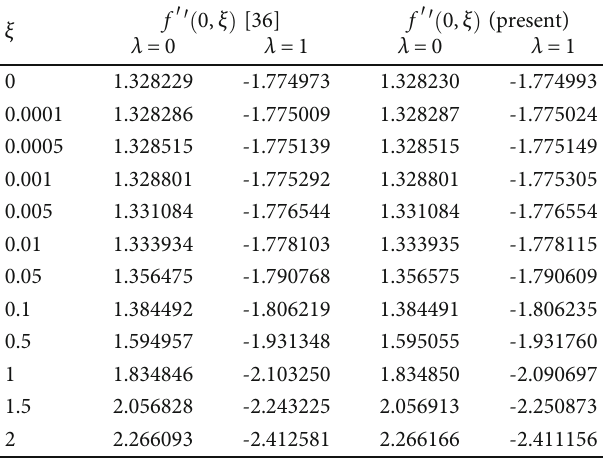
Figure 1: The fl ow coordinate system and the fl ow con fi guration. Table 1: Comparison of the MD-BSQLM approximate solutions of f ′′ ð 0, ξ Þ , against those of Ref. [36] for di ff erent values of λ and ξ when M = 0 , Pr = 0 : 72 , and N r = δ = He = m = r = 0 and in the absence of N t , N b , and Sc